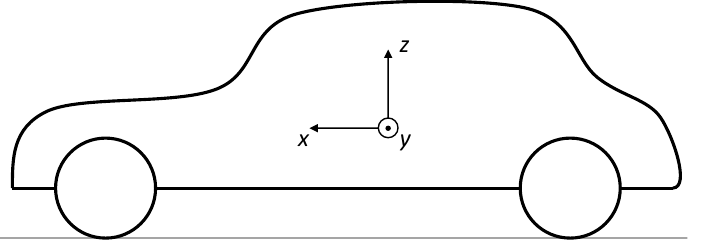
Figure 1. Vehicle reference